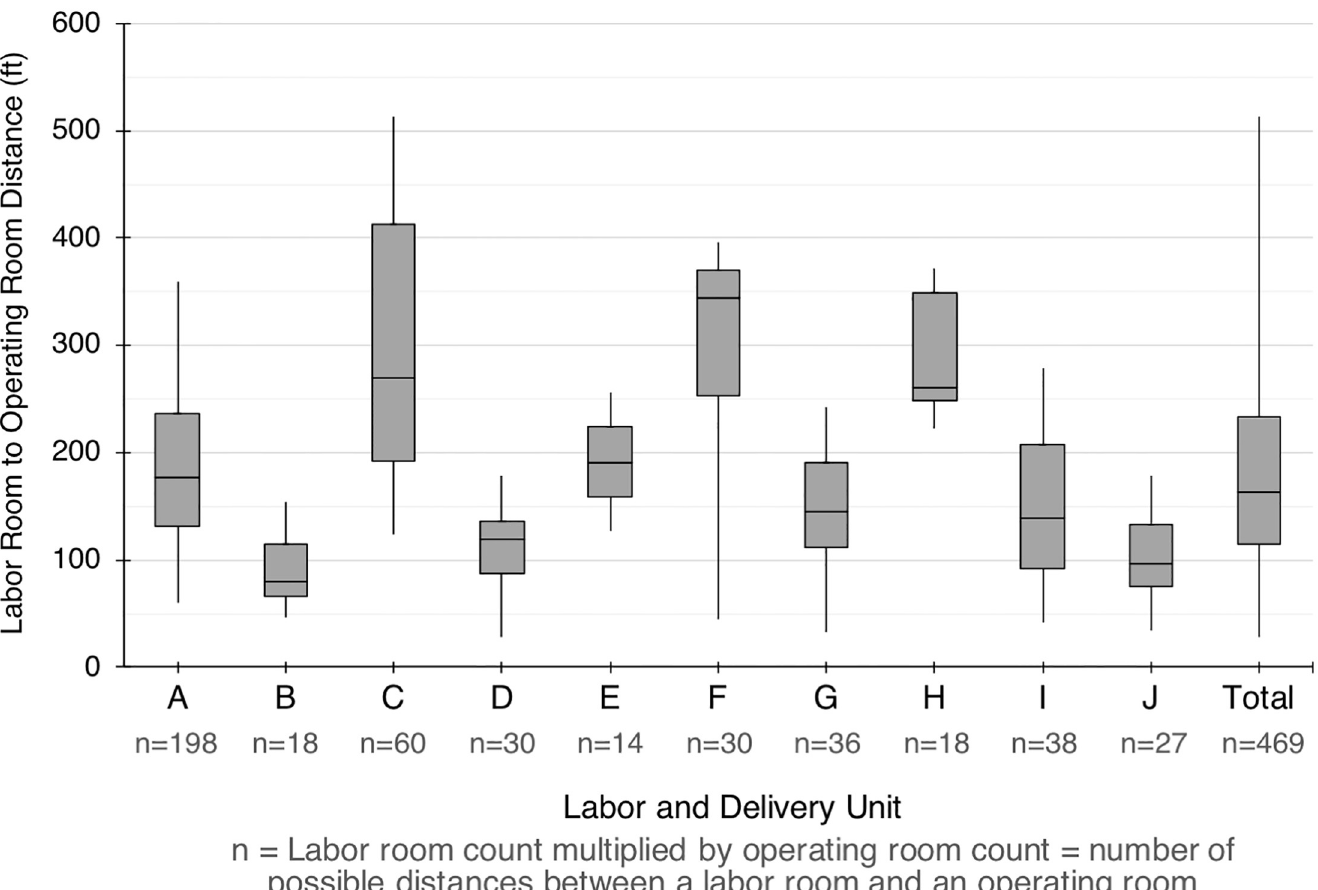
Fig 3. Distribution of labor room to operating room distances by labor unit. Box and whisker plots represent median, first and third quartiles, and range for the distances (ft) from each labor room to each operating room. n = Labor room count multiplied by operating room count. This number represents the number of possible distances required to transport a patient from a labor room to an operating room on L&D (i.e.: for an intrapartum Cesarean section or exam under anesthesia for postpartum hemorrhage).